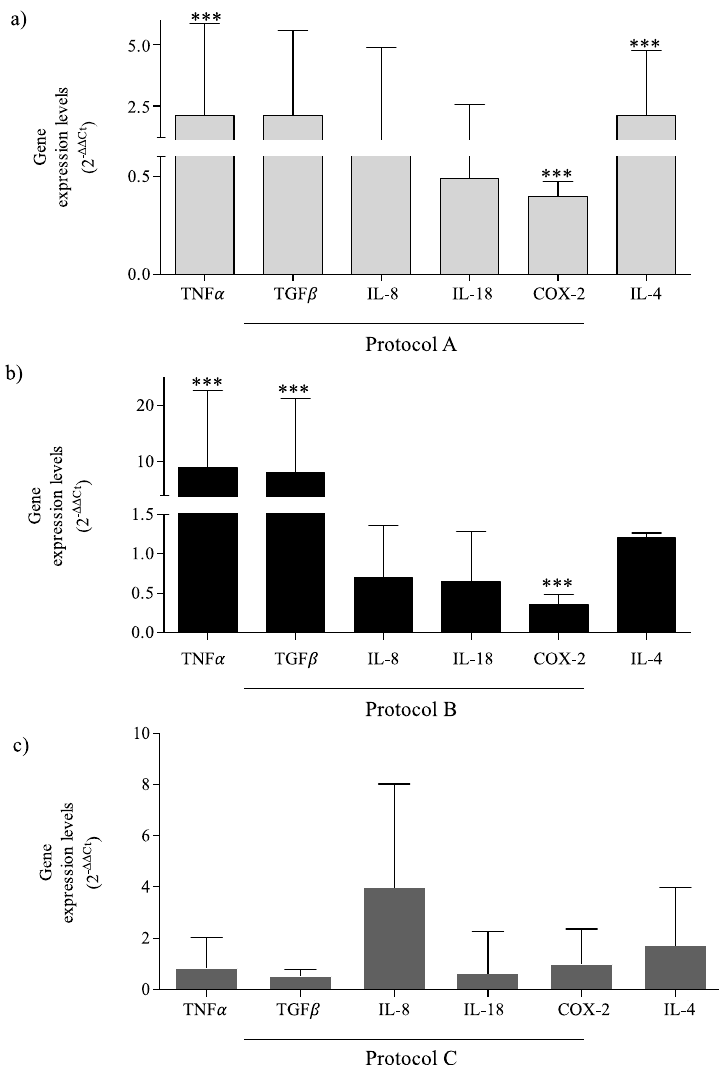
Figure 4. TNF α , TGF β , IL-8, IL-18, COX-2, IL-4 gene expression. ( a ) Inflammatory mediators’ levels in Protocol A-exposed cells relative to sham-exposed cells. ( b ) Inflammatory mediators’ levels in Protocol B-exposed cells relative to sham-exposed cells. ( c ) Inflammatory mediators’ levels in Protocol C-exposed cells relative to sham-exposed cells. Data are reported as mean of 2 − ∆∆ Ct and 95% CI of three independent experiments. *** p -value < 0.001 vs. sham-exposed cells for the same